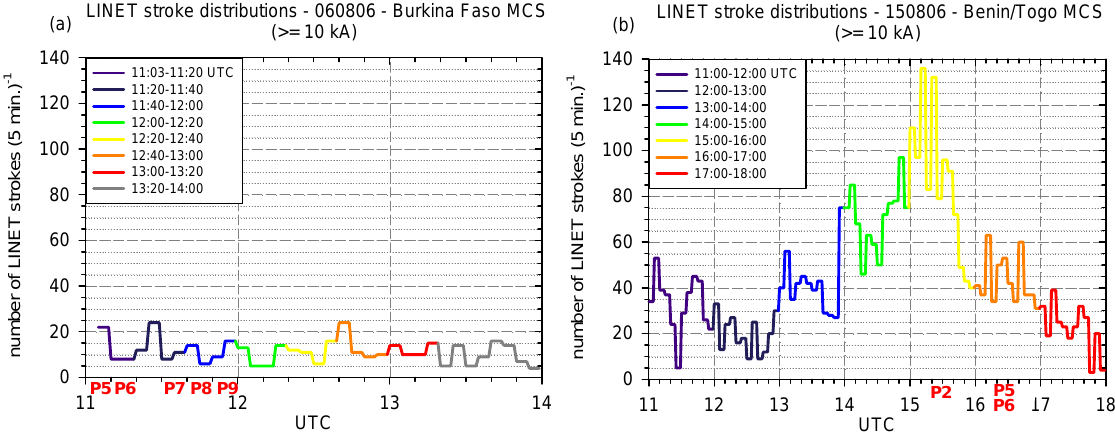
Fig. 11. Time series of LINET stroke rates (colour-coded as in Fig. 10) determined for the selected thunderstorm systems on 6 August (a) and 15 August 2006 (b) (only strokes with peak currents ≥ 10 kA considered). The times when the different anvil penetrations took place are labelled in red below the time scale.